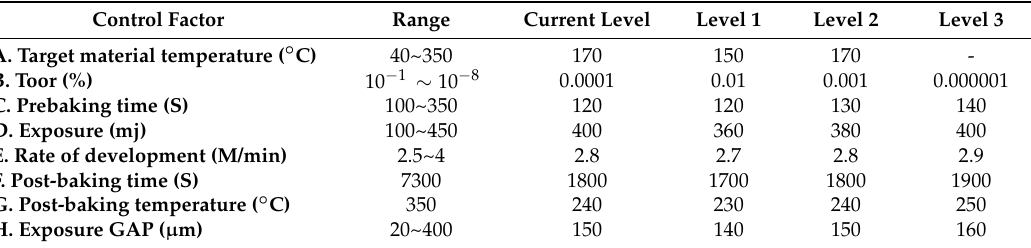
Table 1. Factor level setting for control factors.